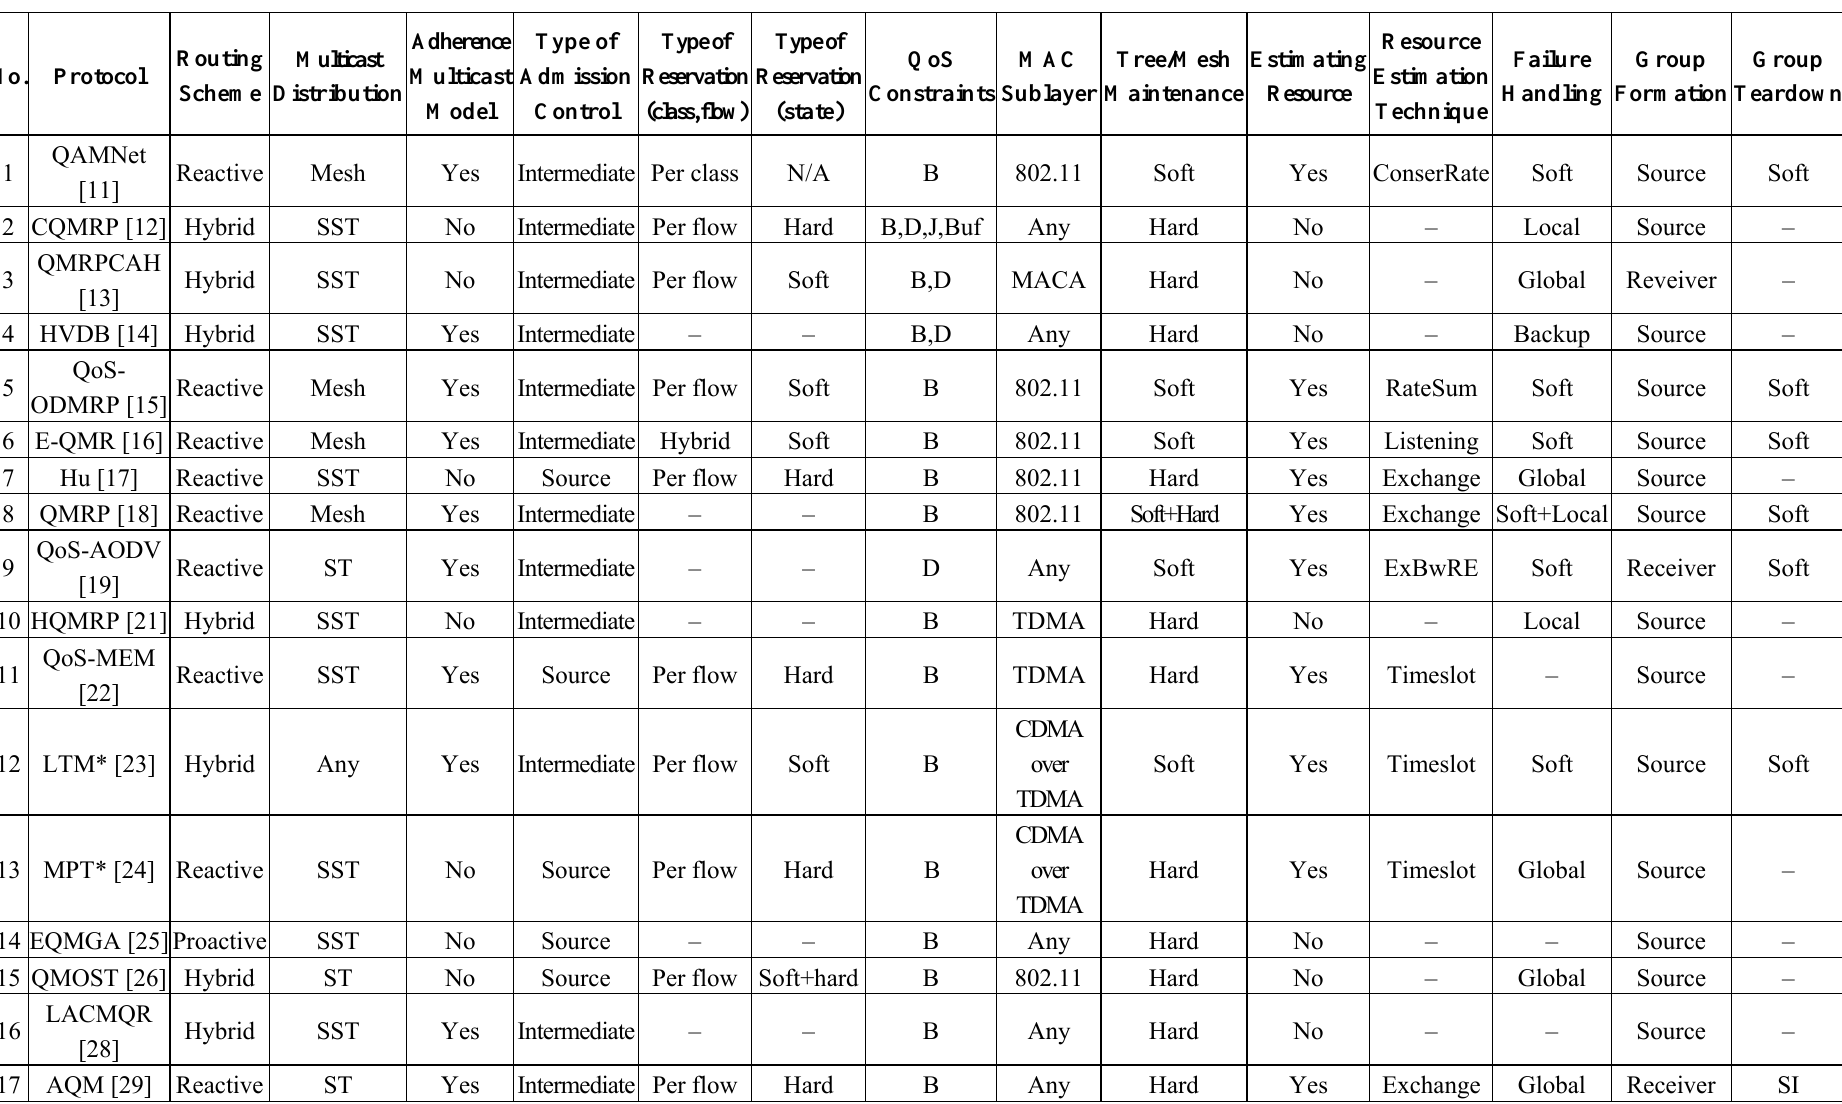
Table 2. Comparison of QoS multicast routing protocols in ad hoc